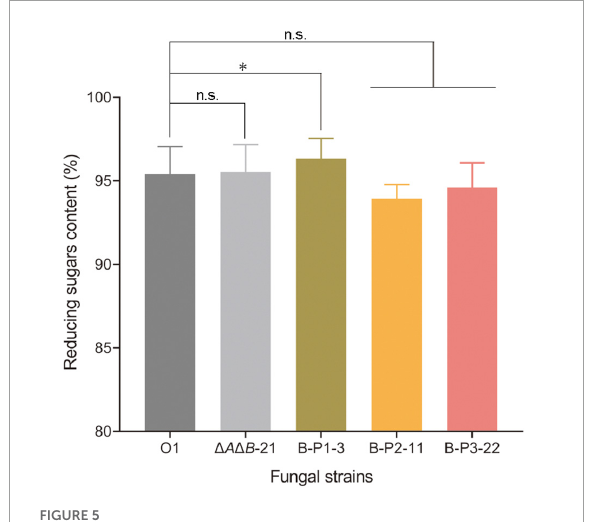
FIGURE5 The reducing sugars content of strain O1, (cid:49) A (cid:49) B -21, and domain-OE strains measured using an SGD-IV automatic reducing sugar detector. Values are means ± SD ( n = 3 repeats). ∗ P < 0.05 (Student’s t -test), n.s., not